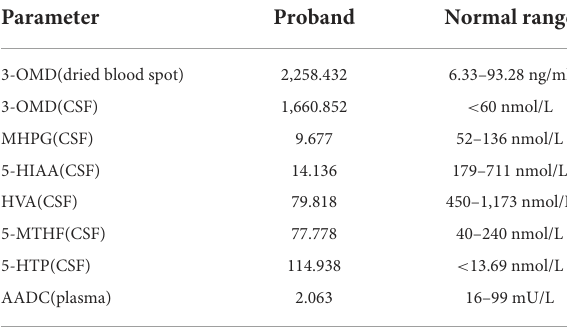
TABLE 1 Laboratory findings of the